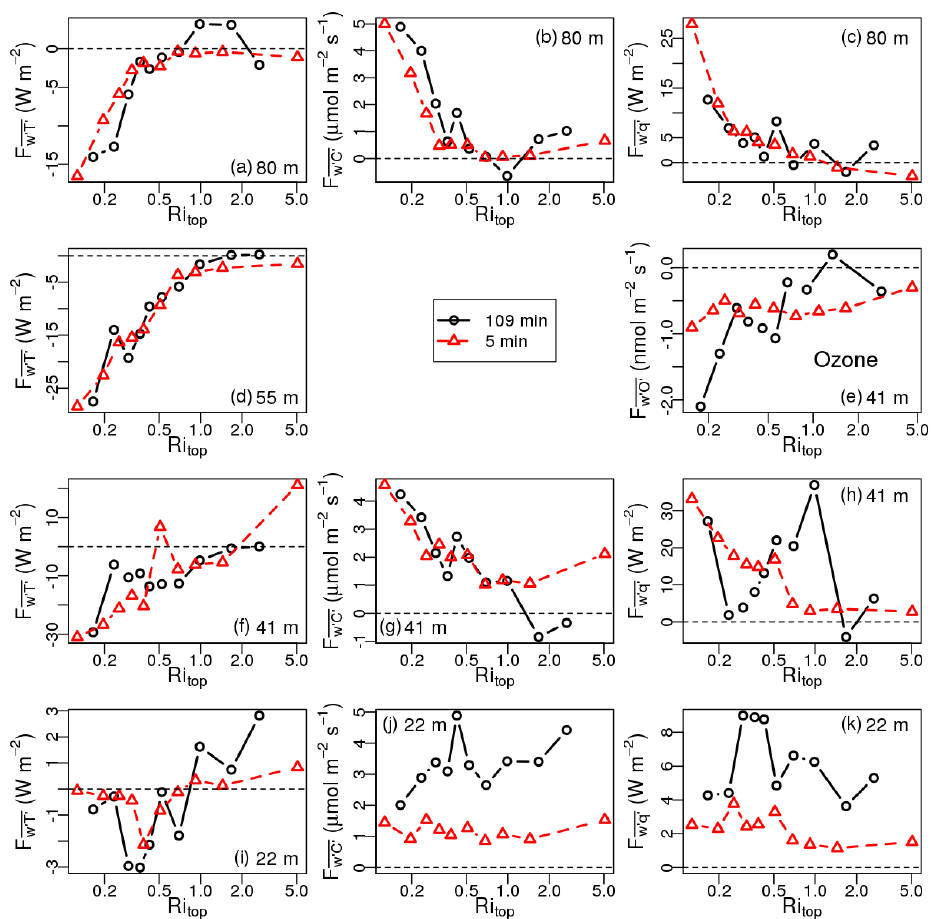
Figure 11. Same as Fig. 9 but for dependence on top Richardson number (Ri top